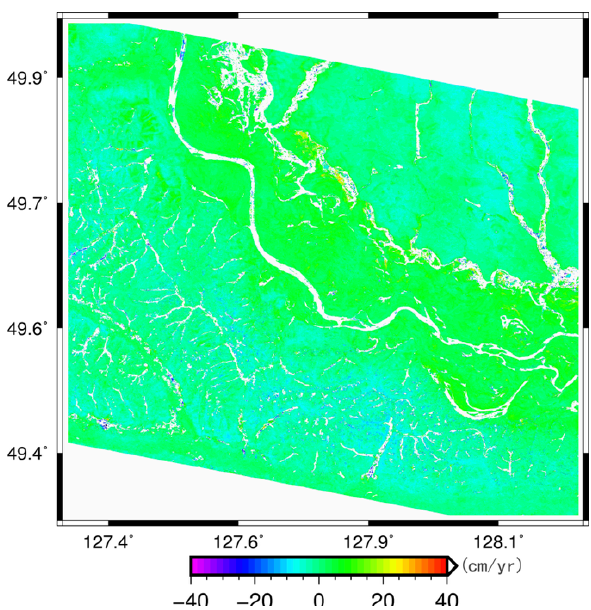
Figure 5. Deformation rate map derived from time series InSAR processing Figure 6. Time series evolution of permafrost